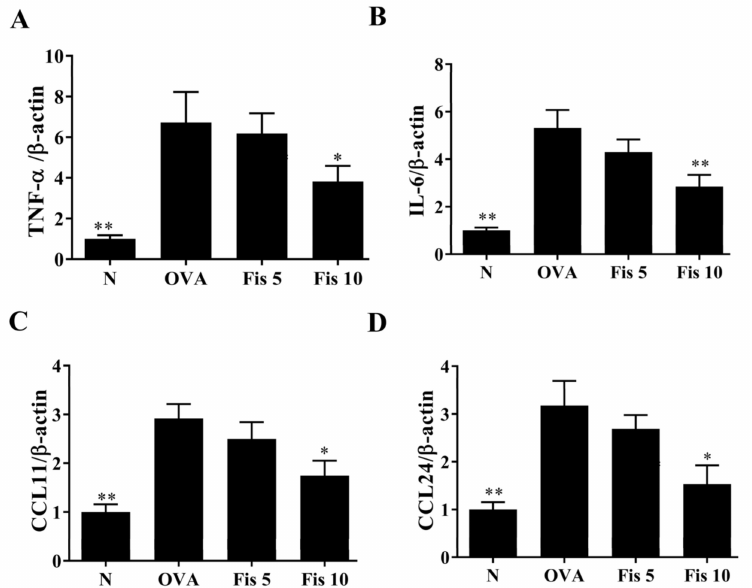
Figure 9. Effects of fisetin on lung tissue in asthmatic mice. Lung tissues were from normal (N) and OVA-stimulated (OVA) mice with or without fisetin (Fis 5, Fis 10) treatment. ( A ) COX-2 expression in the lungs by immunohistochemistry. ( B ) Western blots of COX-2 and ( D ) ICAM-1 expression in lung tissue. ( C ) The fold-change in COX-2 and ( E ) ICAM-1 measured relative to the expression of β -actin. The data are presented as mean ± SEM of three independent experiments, n = 3–5. * p < 0.05, ** p < 0.01, compared to the OVA control group. N: Normal group; OVA: mice sensitized with OVA. OVA-sensitized mice treated with 5 mg/kg or 10 mg/kg fisetin were named as Fis 5 and Fis 10, respectively.